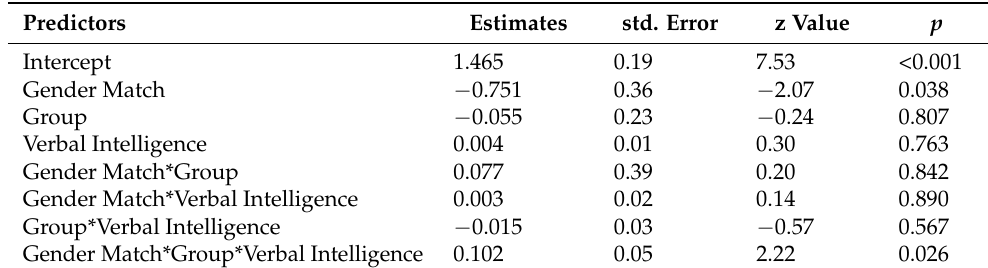
Table A2. Summary of the model for accuracy and the effect of verbal intelligence in the production